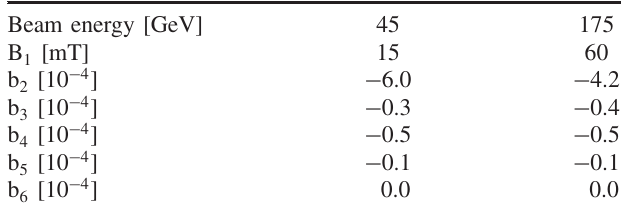
TABLE IX. Simulated 2D field homogeneity for the twin dipole of Fig. 6; the allowed harmonics are at 10 mm